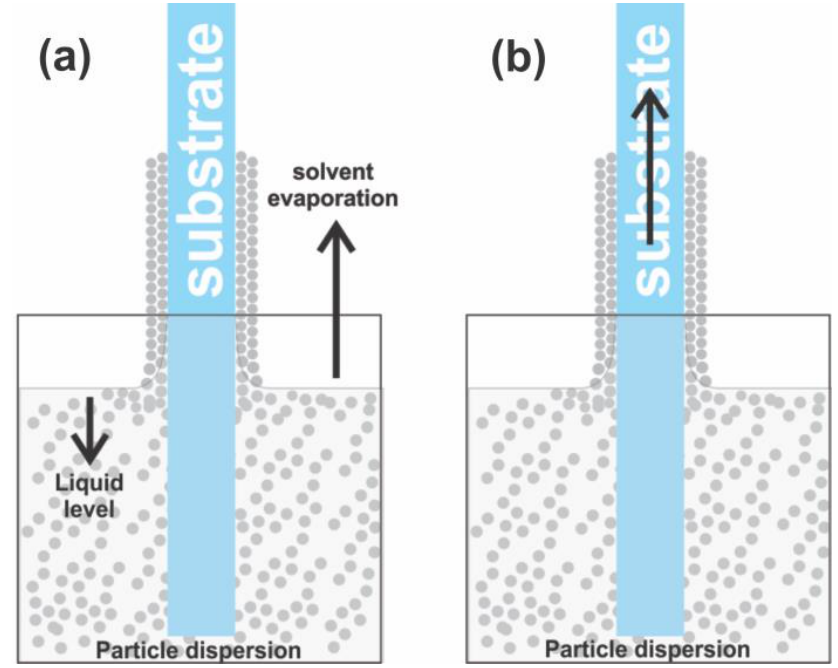
Figure 1. C-PC elaboration by solvent volatilization ( a ) or vertical lifting deposition method ( b ). Although capable of producing good quality crystals, the solvent volatilization– convective assembly method is slow and has low uniformity between deposits in terms of thickness and reflectance spectrum characteristics, most likely due to slight variations in temperature, humidity, arrangement geometry, and particle suspension properties that influence the outcome. As C-PCs find more applications in the manufacturing of advanced materials, the development of a robust methodology for C-PC fabrication that yields a large quantity of crystals with an acceptable and constant reflectance spectrum in a short period of time is critical. Despite its importance, the fabrication process and scale-up of